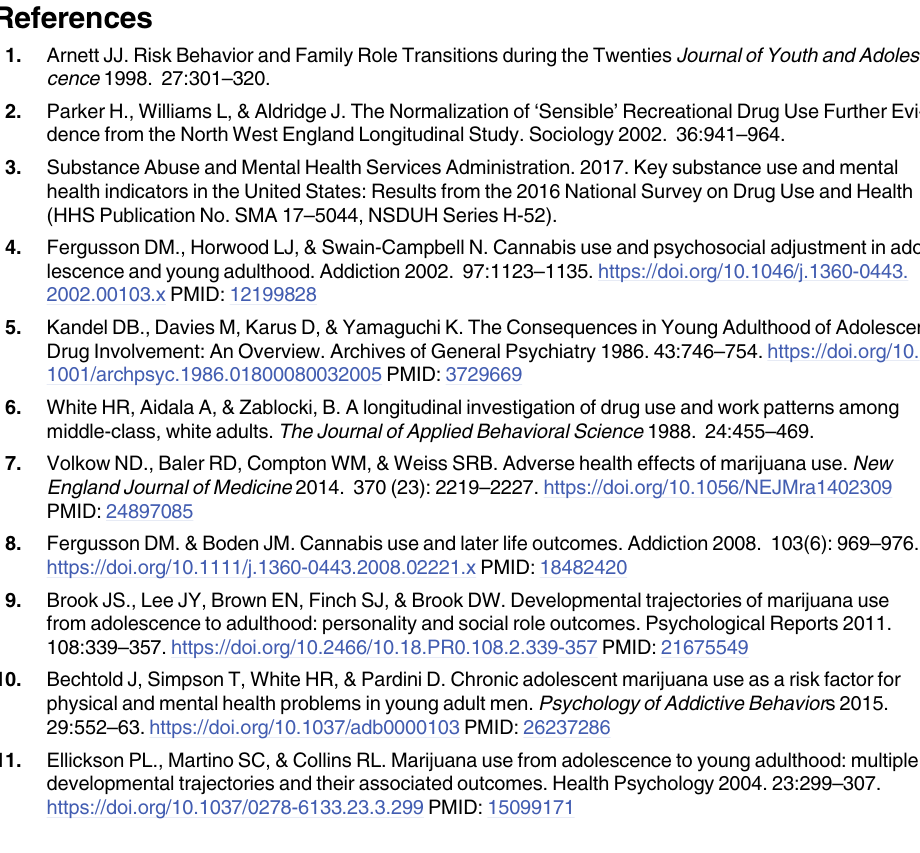
S1 Table. Cognitive aptitude and heterogeneous trajectories of marijuana use with inclu- sion of peer drug use: Full models (n = 3,903)